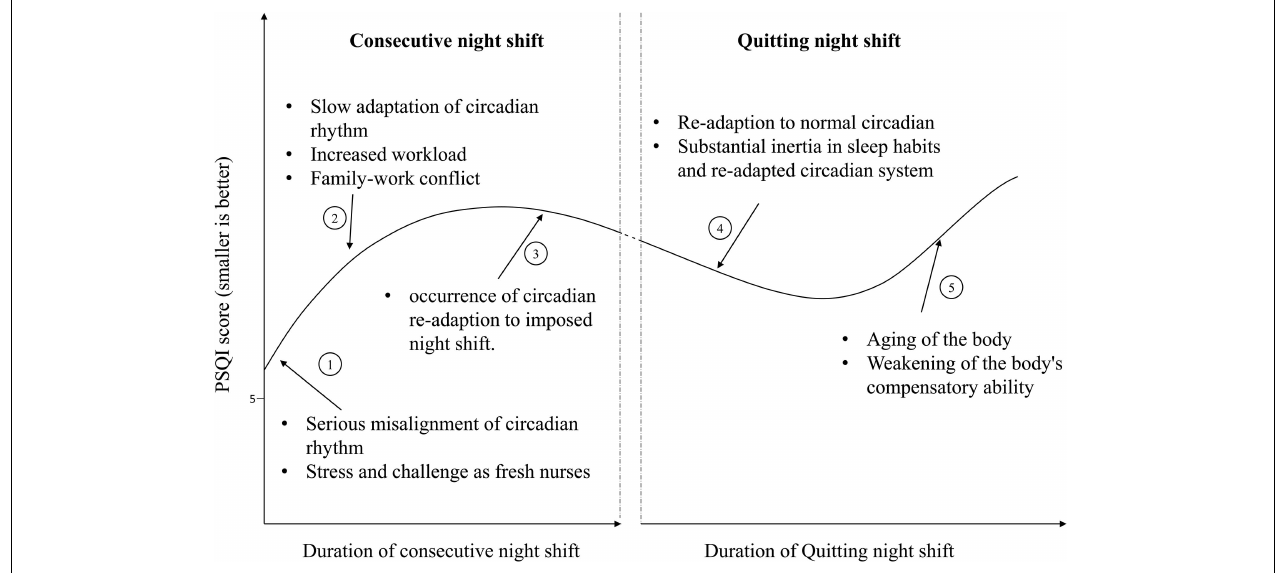
FIGURE 4 | Possible reasons for change in Pittsburgh Sleep Quality Index (PSQI) during consecutive night shifts based on the cross-sectional data and change in PSQI after quitting night shifts based on the hypothetical prospective